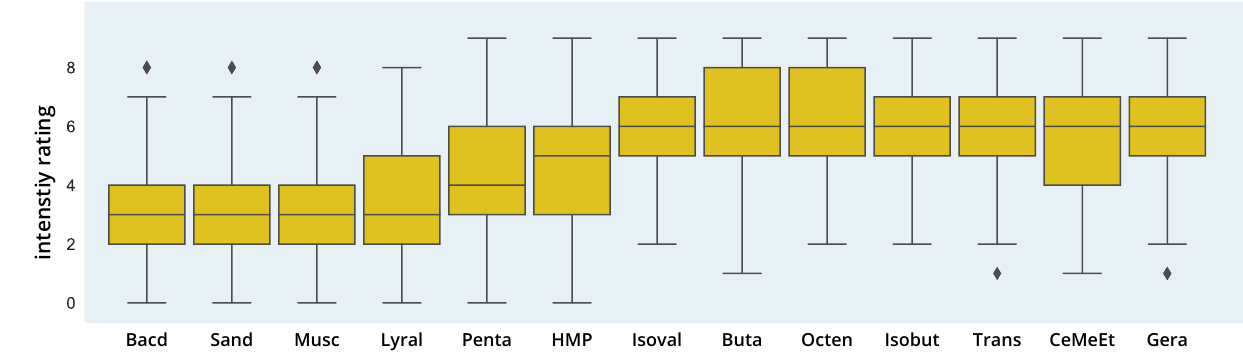
Figure 4. Intensity Ratings. The figure shows boxplots for intensity ratings (from 0 = not perceived to 9 = extremely intense) of different odor molecules. Rhombs display outliers.